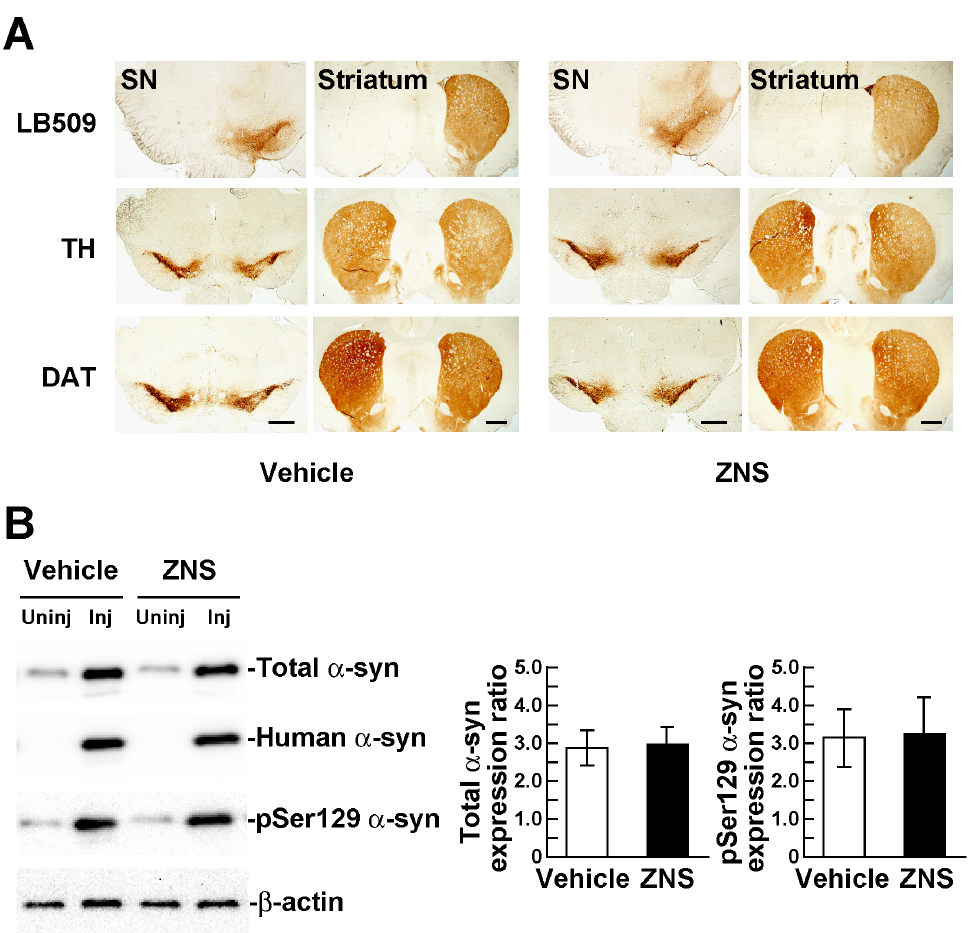
Figure 1. rAAV-mediated expression of A53T a -synuclein in the rat nigrostriatal system. ( A ) rAAV-A53T a -synuclein was unilaterally injected in the substantia nigra pars compacta. Immunohistochemical images of the rat substantia nigra (SN) and striatum at 2 weeks after viral injection. Upper panels show sections immunostained with LB509 antibody that recognizes total human a -synuclein, including phosphorylated and nonphosphorylated forms. Middle and bottom panels show sections immunostained with antibodies for tyrosine hydroxylase (TH) and dopamine transporter (DAT), respectively. Left and right panels show sections of rats treated with vehicle and zonisamide (ZNS), respectively. Scale bars, 1 mm. ( B ) Left panels shows western blotting of the rat ventral midbrains at 2 weeks after viral injection. 1% Triton X-100-soluble extracts (5 m g/lane) were analyzed by western blotting with Syn-1 (total a -synuclein), LB509 (human total a -synuclein), and EP1536Y (phosphorylated a -synuclein) antibodies. For loading control, the same amounts of samples were blotted with b -actin antibody. Right graphs show the ratios of the total a -synuclein and phosphorylated a -synuclein expression levels in the ZNS group relative to those in the vehicle group. Band intensities were normalized to b -actin to correct loading variations between lanes. Data represent the means 6 SD. doi:10.1371/journal.pone.0089076.g001 densities of TH-positive fibers at 8 weeks after viral injection were (89.0 6 11.1%, n = 7) and 8 weeks (88.3 6 4.8%, n =7) after viral 21.8 6 6.7% (n= 6) (Figure 3A). Two-way ANOVA (group 6 time) injection (Figure 3B). demonstrated a significant main effect of group [ F (1,30) =17.210, In rAAV-A53T a -synuclein-injected rats, we then analyzed the P , 0.001], a significant main effect of time [ F (2,30) = 170.728, P , densities of DAT-positive striatal fibers. Two-way ANOVA (group 0.001], and a significant group 6 time interaction [ F (2,30) = 4.113, 6 time) demonstrated a significant main effect of group P = 0.026]. The data were then analyzed by a Bonferroni’s post hoc [ F (1,30) = 42.571, P , 0.001], a significant main effect of time test. At 2 weeks after viral injection, there was no difference in the [ F (2,30) = 237.301, P , 0.001], and a significant group 6 time densities of TH-positive fibers between the vehicle (76.8 6 4.6%, interaction [ F (2,30) = 6.257, P =0.005]. Decreased densities of n =6) and ZNS (77.2 6 9.0%, n= 6) groups ( P =0.921) (Figure 3A). DAT-positive striatal fibers were significantly suppressed in the However, ZNS treatment significantly suppressed loss of striatal ZNS group (46.1 6 5.7%, n = 6), as compared with the vehicle group (24.9 6 7.8%, n= 6) at 4 weeks after viral injection ( P , weeks (34.5 6 8.1%, n= 6, P = 0.004) after viral injection 0.001) (Figure 3C). At 8 weeks after viral injection, the densities of (Figure 3A). In rAAV-GFP-injected rats, the vehicle group did DAT-positive striatal fibers in the ZNS group (30.3 6 10.6%, n= 6) not show progressive loss of TH-positive striatal fibers at 8 weeks were also higher than those in the vehicle group (13.9 6 6.5%, (84.0 6 7.2%, n= 7) compared with that at 4 weeks (87.6 6 8.1%, n =6, P , 0.001) (Figure 3C). In rAAV-GFP-injected rats, there n =6) after viral injection (Figure 3B). Also, ZNS treatment did not were no significant differences in the densities of DAT-positive affect the number of TH-positive striatal fibers at 4 weeks